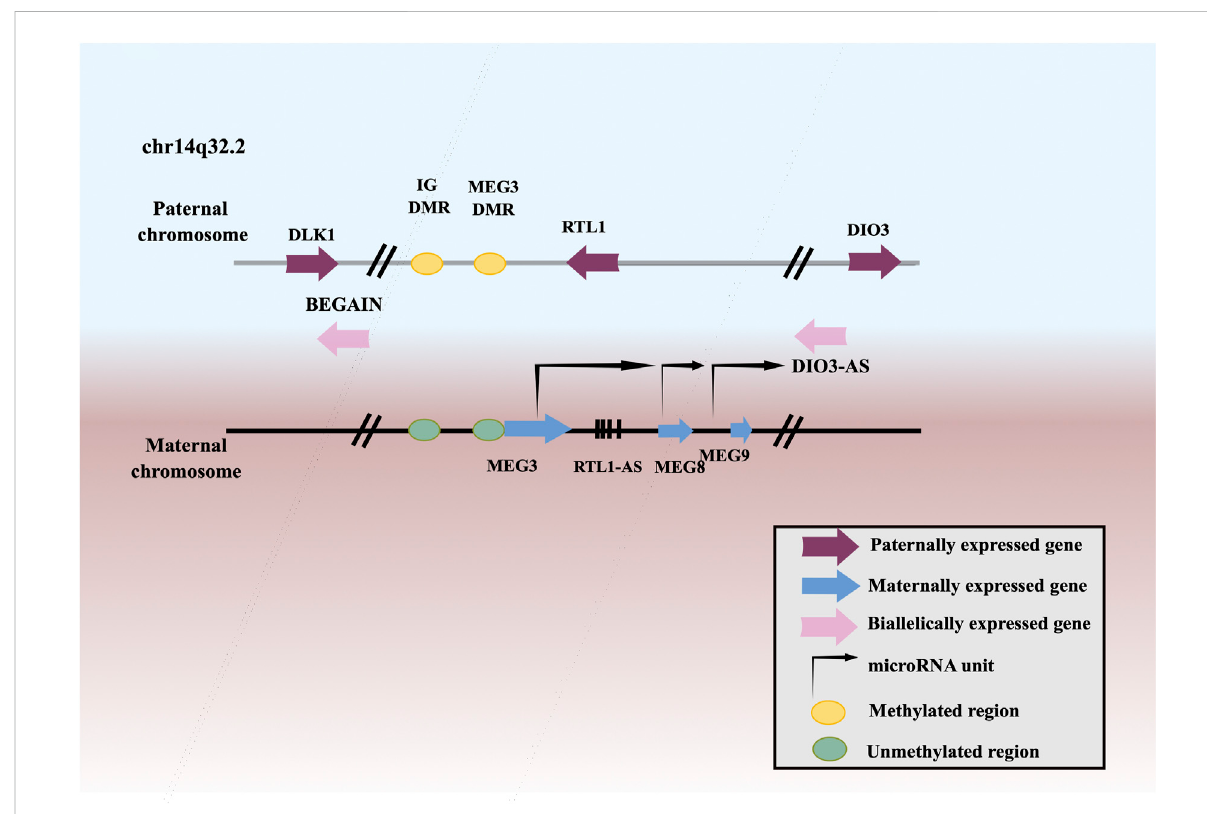
FIGURE 1 Schematic representation of the DLK1 – MEG3 locus on human chromosome